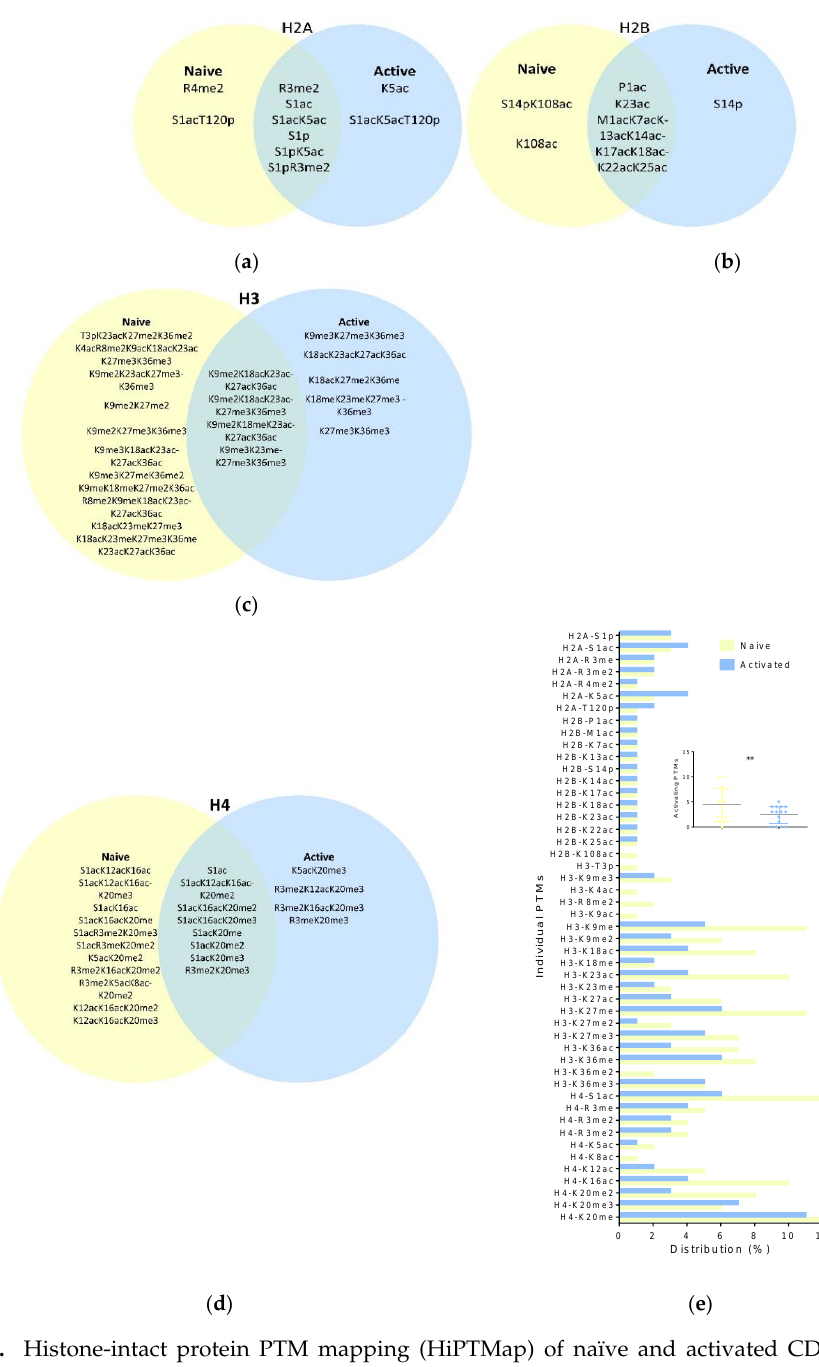
Figure 2 . Histone-intact protein PTM mapping (HiPTMap) of naïve and activated CD8 T cells. ( a – d ) Histones purified from naïve (CD8 hi CD44 low CD43 low CD25 low ) or activated T cells (CD8 hi CD44 hi CD43 hi CD25 hi ) purified by FACS of splenocytes from mice 9 days after intranasal infection with influenza and subjected to RPLC – MS/MS using Orbitrap Velos with alternative collision-induced dissociation (CID)/alternating electron transfer dissociation (ETD). Raw datasets were searched against the mouse top-down database. PTMs including acetylation, mono-, di-, and tri-methylation and phosphorylation were detected; ( e ) the individual modifications from each proteoform were combined to yield the sum of each PTM per core histone. A Wilcoxon matched-pairs signed-rank test was performed ( p < 0.0001) with pairing evaluated by Spearman correlation ( p < 0.0001). Inset: the number of enhancer PTMs (H4-K8ac, H3-K36me2, H3-K9ac, H2B-K12ac, H4-K5ac, H3-K36me3, H4-K12ac, H4-R3me2, H3-K36ac, H3-K27ac, H2A-S1p, H4-K16ac, H3-K23ac, H3-K18ac, and H2A-K5ac) were compared for the activated and naïve with paired t-test ( p = 0.0046).